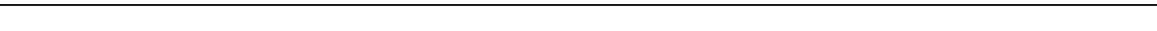
Fig. 6 Factor XIIIA in IMs promotes fi brin cross-linking and LUSC invasion. a Relative mRNA expression of F13a1 from sorted IMs and RMs, n = 3 mice. b Immuno fl uorescent (IF) imaging of IMs and RMs comparing FXIIIA (red) expression. c Dual staining for FXIIIA (red) and CD11b (green) in IMs. Contents of dotted white box are enlarged under each panel. d Confocal imaging of IMs for FXIIIA (red). White arrows point toward podosome-like structures. Scale bar: 5 μ m; nuclei were stained with Hoechst (panels b – d ). e Fibrin cross-linking patterns by western blotting using a polyclonal anti-human fi brin(ogen) antibody using freshly sorted IMs and RMs (Low = 25k cells, High = 100k cells), with or without the FXIIIA-inhibitor, T101. f Percent invadopodia of LN4K1 cells growing in either unfractionated (UF Fgn, left) or Peak 1 (FXIIIA-depleted) fi brinogen (right). White arrows show evidence of invadopodia. Scale bar 50 μ m. Data are averages± s.e.m. P -values obtained with Student ’ s t-test. g Schematic of co-culture model (top). Representative images of LN4K1-GFP cells growing in either UF Fgn or Peak 1 with or without low (100k) or high (300k) IMs. FDR = 0.0001 for all statistical comparisons shown. Groups in e + g treated with the T101 were dosed at 50 μ M. Scale bar 12.5 μ m. Data are averages± s.e.m. P -values were obtained with Student ’ s t-test. h Invaded LN4K1-GFP cells per high power fi eld (HPF) at 24 h following seeding into either UF Fgn or Peak 1 Fgn alone or co-cultured with IMs with or without T101 (50 μ M). FDR < 0.01 for all statistical comparisons shown. i Representative images (left) of LN4K1-GFP cells co-cultured with IMs from either wild-type or F13a1 − / − mice. Number of invadopodia positive LN4K1-GFP cells (right) per HPF at 24 h when growing in UF Fgn or Peak 1 Fgn alone or co- cultured with IMs from either wild-type or F13a1 − / − mice. Scale bar 12.5 μ m. Data are averages ± s.e.m. P -values were obtained with Student ’ s t-test. FDR < 0.01 for all statistical comparisons shown. ** P < 0.01, *** P <